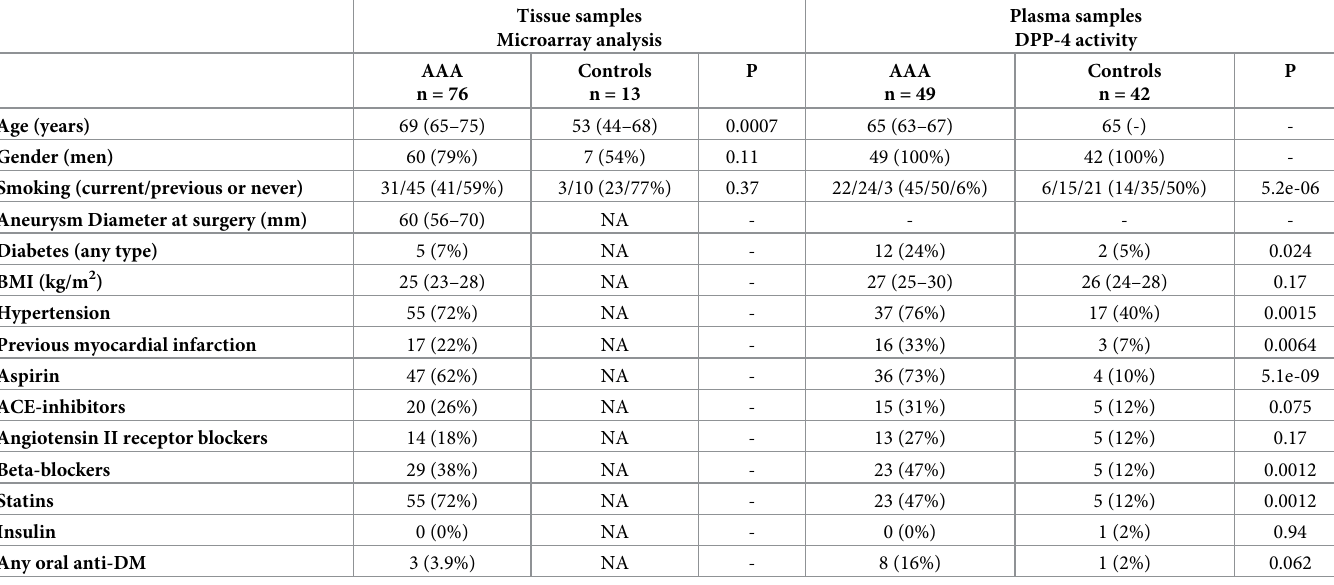
Table 1. Clinical characteristics of control subjects and aneurysm